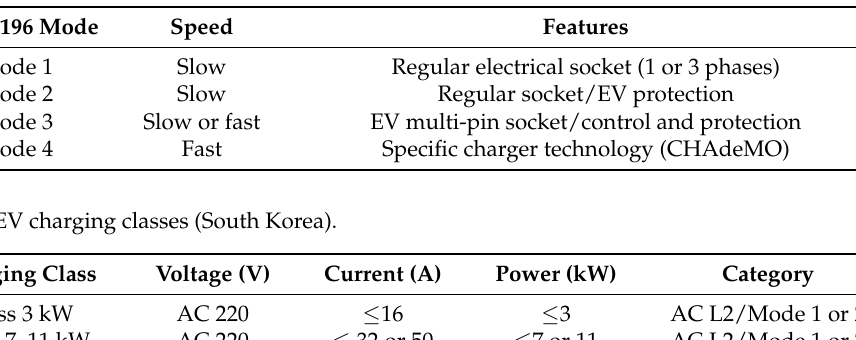
Table 2. EV charging modes based on IEC 69196 (Europe).